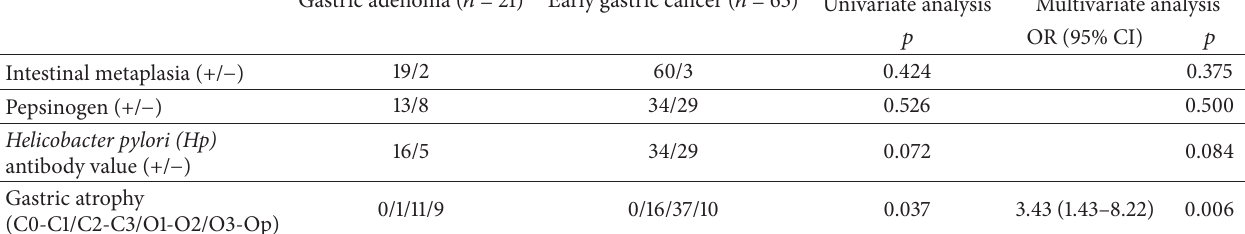
Table 2: Histological outcomes and